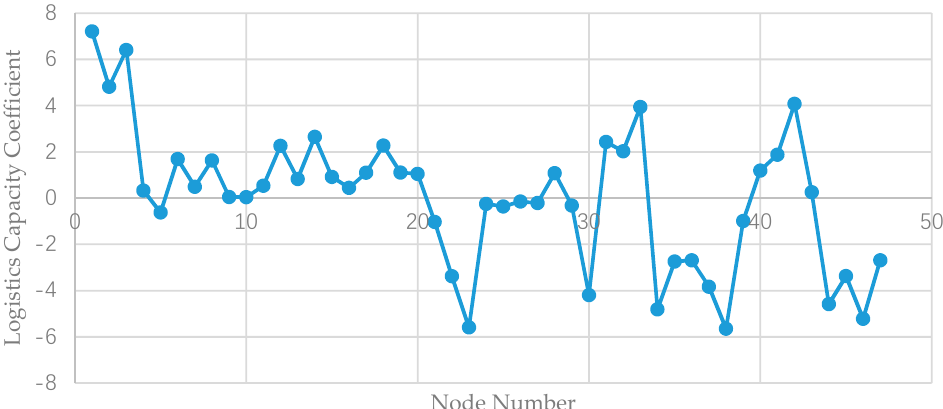
Figure 4. Logistics capacity coefficient of each node.